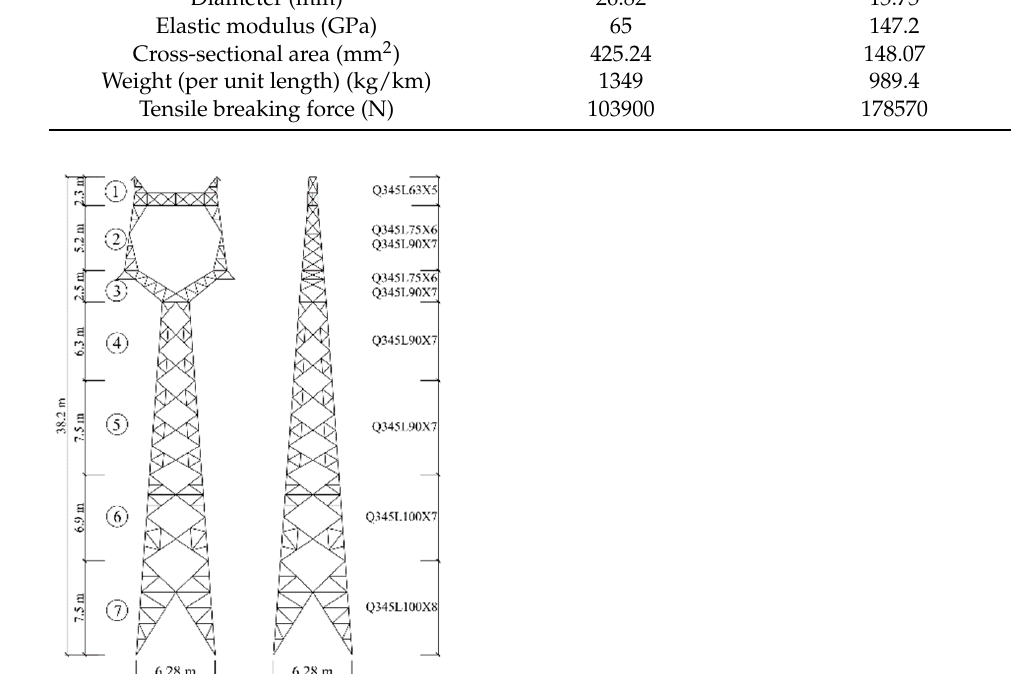
Figure 2. Segmentation of the tower and parameters of main leg members.